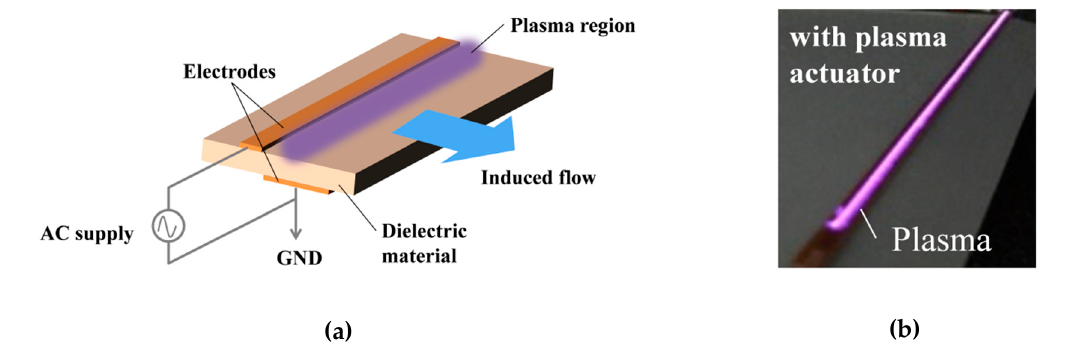
Figure 1. A dielectric-barrier-discharge plasma actuator. ( a ) Schematic sketch; ( b ) Picture of the present actuator.